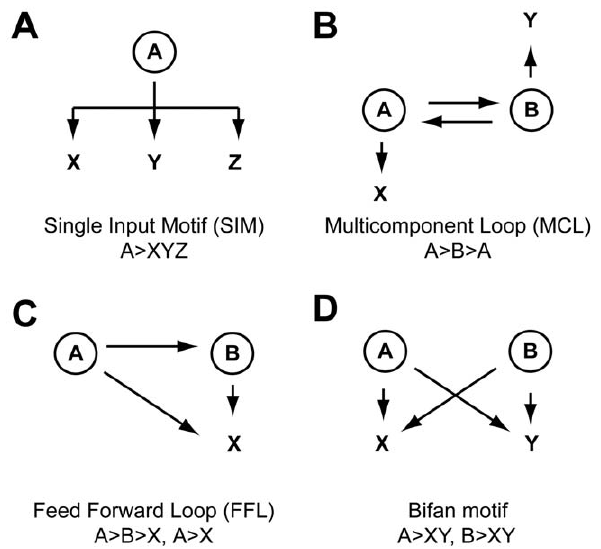
Figure 1. Networks motifs found in the H.pylori TRN. A . Single input motif (SIM); a single transcription factor A regulates a set of operons (X, Y, Z); frequently A is autoregulated. B . multicomponent loop (MCL); transcription factor A regulates another regulator B, which in turn can regulate the transcription of A; each regulator can also control transcription of a separate set of target operons. C . Feed forward loops (FFLs) are three node motifs, occurring with high frequency in prokaryotic TRNs. A top regulator, A, which controls a second regulator, B, and a target gene, X, which is regulated by both A and B. The regulators in this motif (A, B) have an asymmetric position and hierarchy, as A regulates two targets, while B only one. According to the net signs feeding into X, FFL can be coherent (same sign) or incoherent (opposite sign), negative or positive, conferring different response kinetics [13] D . Bifan motif (BM); a set of operons (X, Y) is each regulated by the combination of two (A, B; BM) or multiple (A, B, C, etc.; multi input motif, not shown) transcription